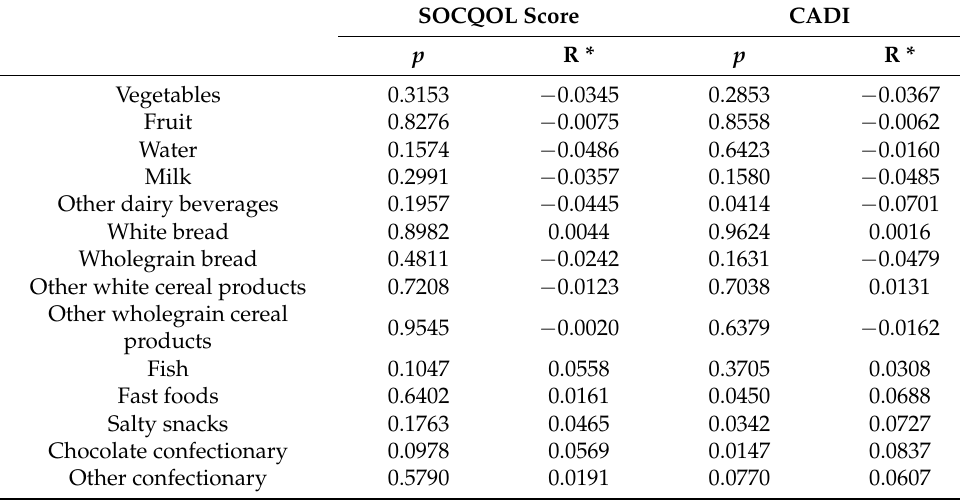
Table 5. The analysis of correlations between the consumption of food items within the Acne-specific Food Frequency Questionnaire (Acne-FFQ) and the acne-related quality of life, assessed based on the Social Quality of Life (SOCQOL) Score calculated from the Acne Quality of Life (AQoL) Scale results, as well as the Cardiff Acne Disability Index (CADI) calculated from the Acne Disability Questionnaire (ADQ) in the group of Polish female adolescents participating in the